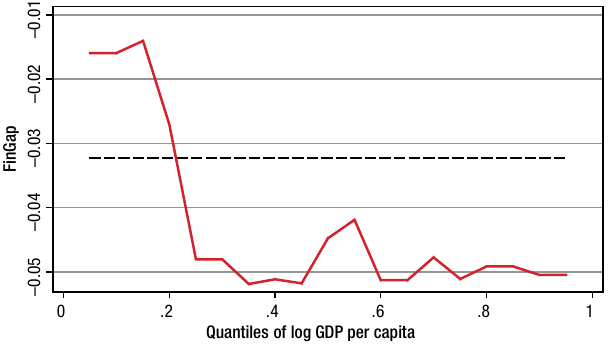
Fig. 3. Quantile coefficients of financial structure gap